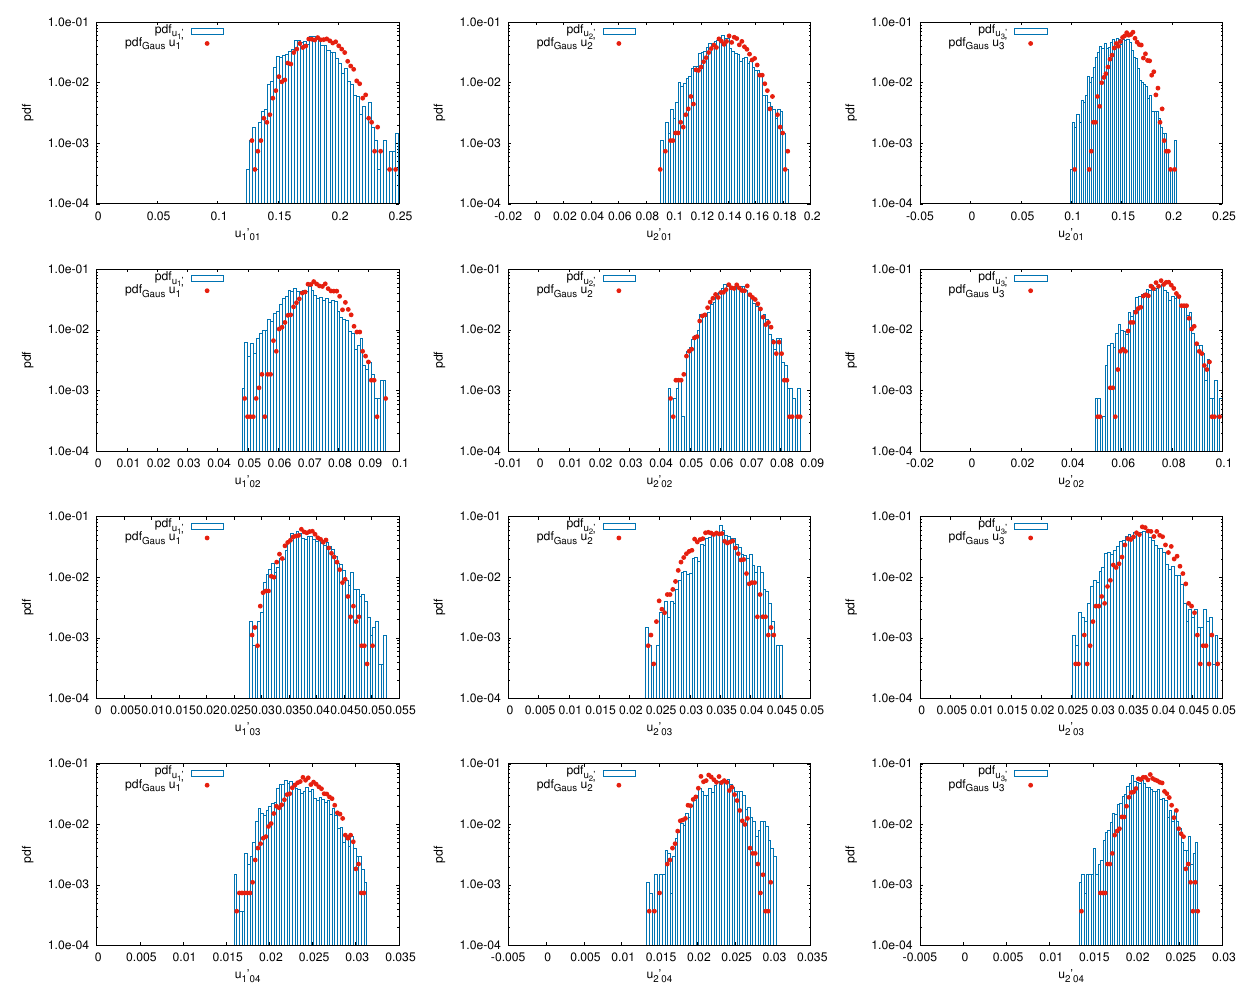
Figure 19. Probability Density Function (PDF) of velocity components u 1 ( left ), u 2 ( center ), and u 3 ( right ) compared with normal Gaussian distributions. Top to bottom: probes P i , with i from 1 to